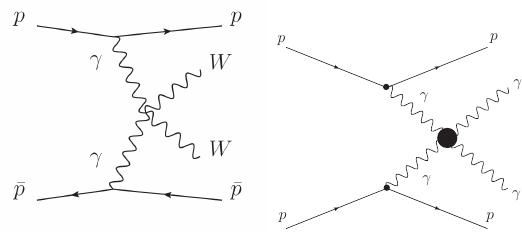
Figure 1: Example of WW and γγ exclusive production by photon exchanges.